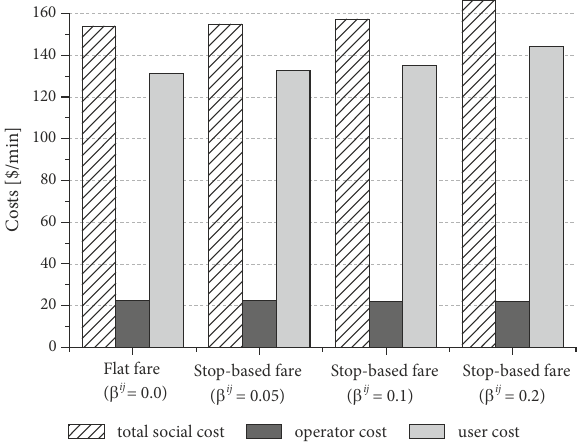
Figure 7. Optimal results of a flat fare and stop-based